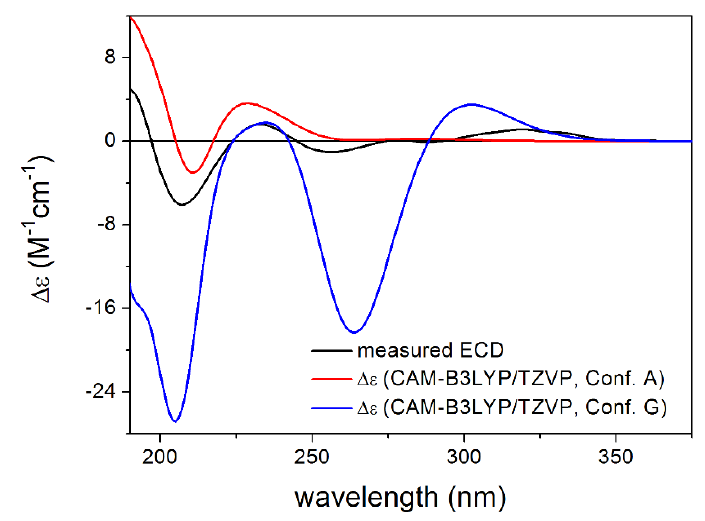
Figure 7. Comparison of the experimental ECD spectrum of 3 measured in MeCN with the CAM- B3LYP/TZVP PCM/MeCN spectra of conformers A and G of (6 R ,7 R ,8 S ,9 R ,10 R )- 3 , as the lowest-energy representatives of groups A and B. Level of optimization: CAM-B3LYP/TZVP PCM/MeCN.